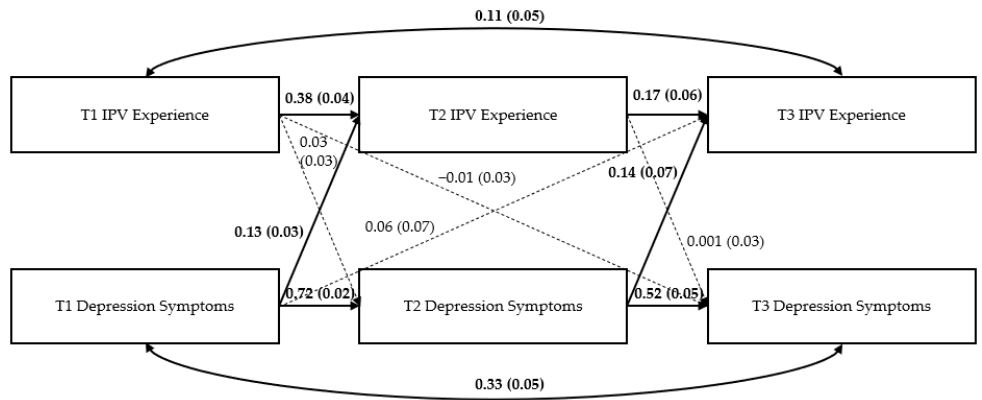
Figure 3. Results of the depression model. Note: Numbers represent standardized path coefficients (β) and standard errors (SE) in parentheses. Bolded lines and coefficients are significant; dotted lines are nonsignificant ( p > 0.05); n = 1842 women due to missing data on some